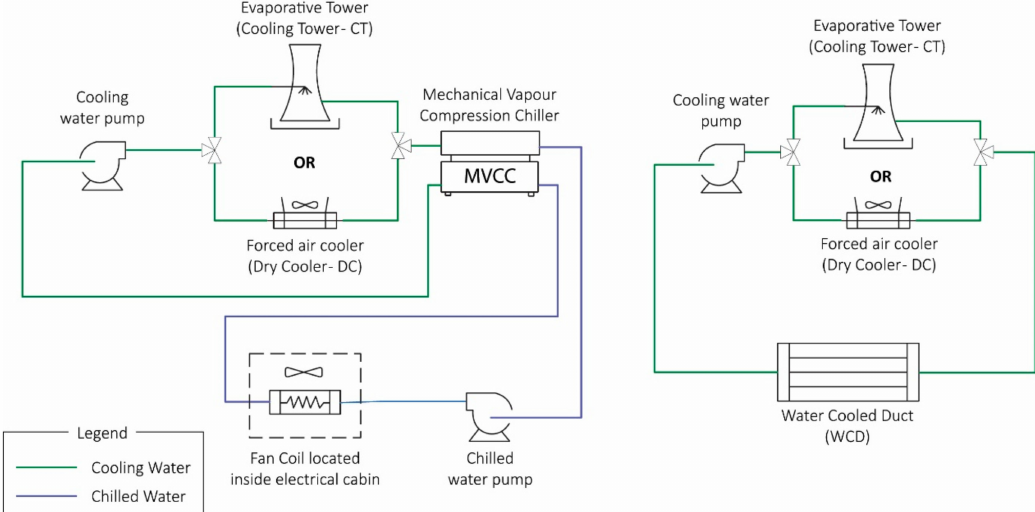
Figure 1. Mechanical vapour compression chiller schematic